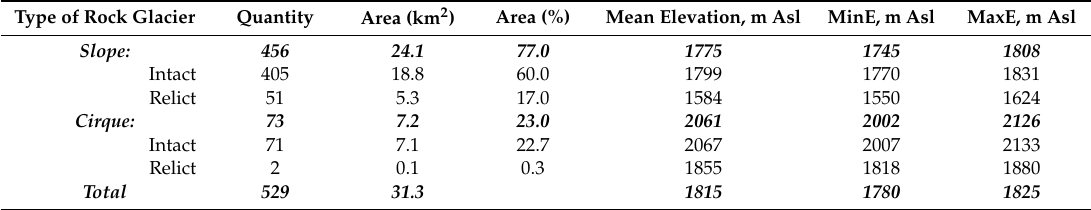
Table 2. Statistics of Rock Glaciers of the Suntar-Khayata Range.